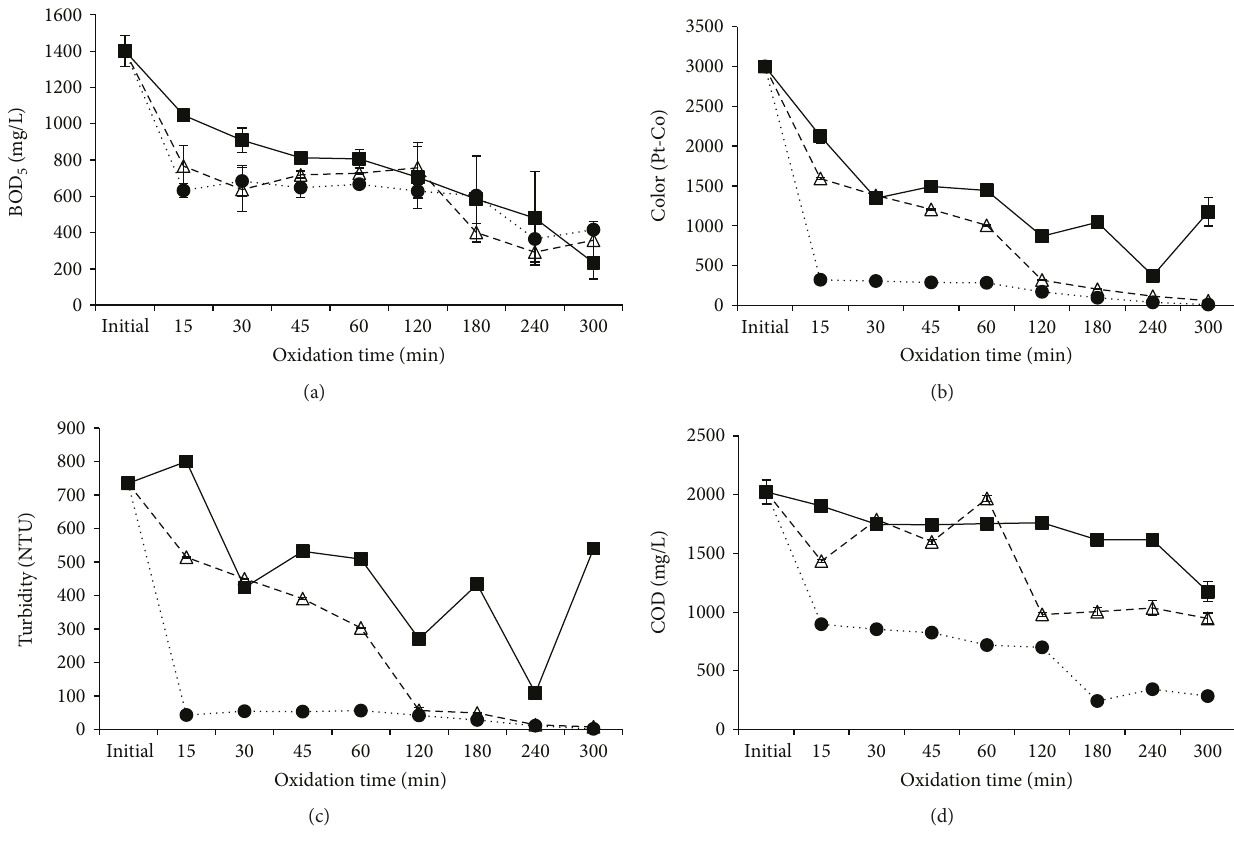
Figure 4: Behavior of (a) BOD , (b) color, (c) turbidity, and (d) COD. Applying 3.5mA · cm − 2 , at pH5.23 ( ■ ), 7 ( Δ ), and 10 ( ● ). 5